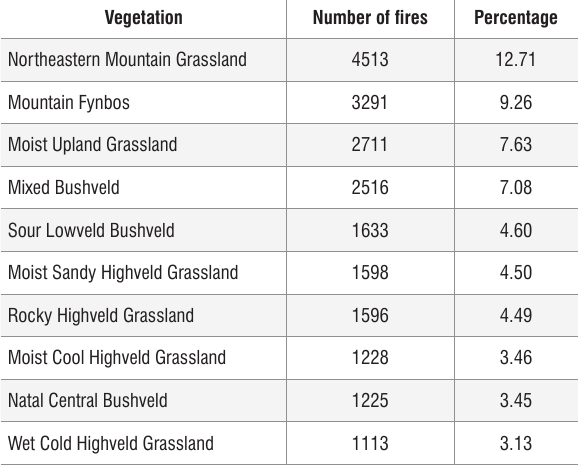
Total number of fires in South Africa per vegetation class and percentage of total fires for the 11-year period from